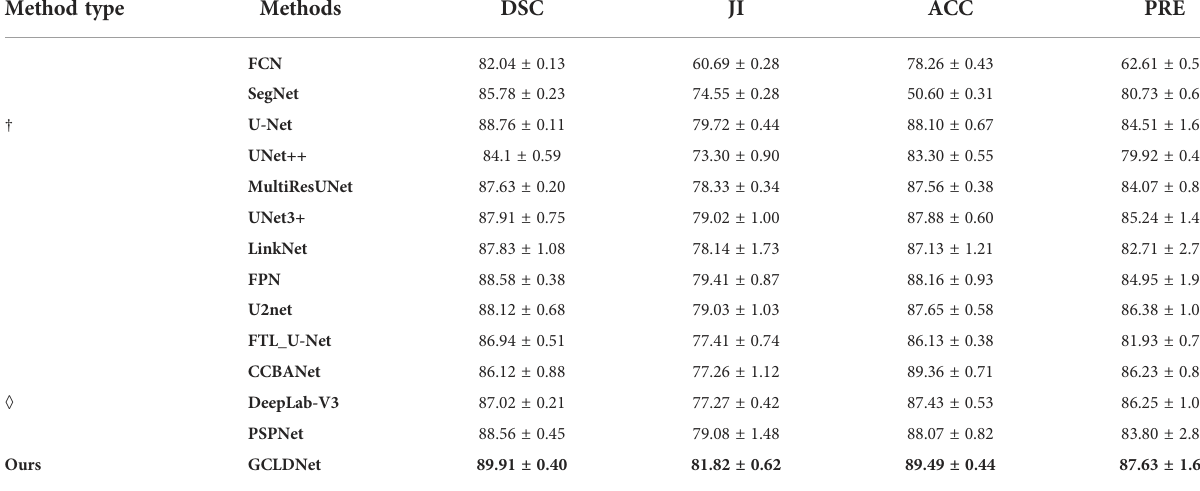
TABLE 2 Segmentation performance of different models on the BOT dataset.